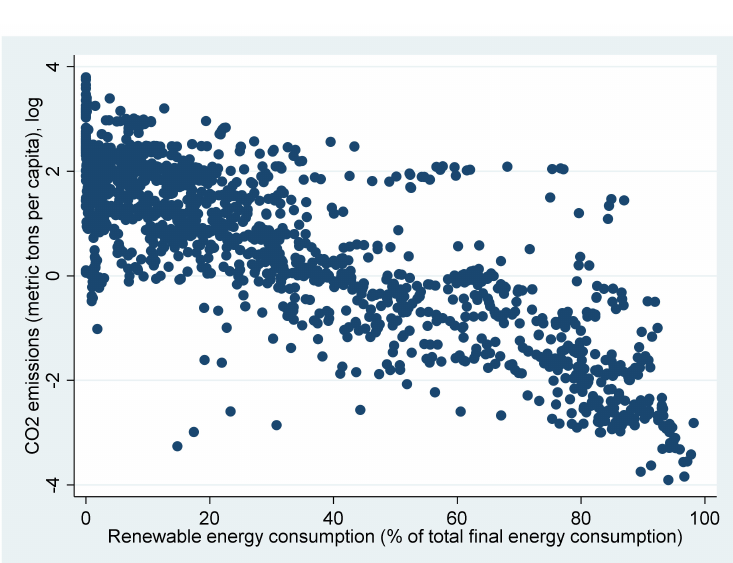
Figure 1. Scatterplot between renewable energy and CO 2 emissions.